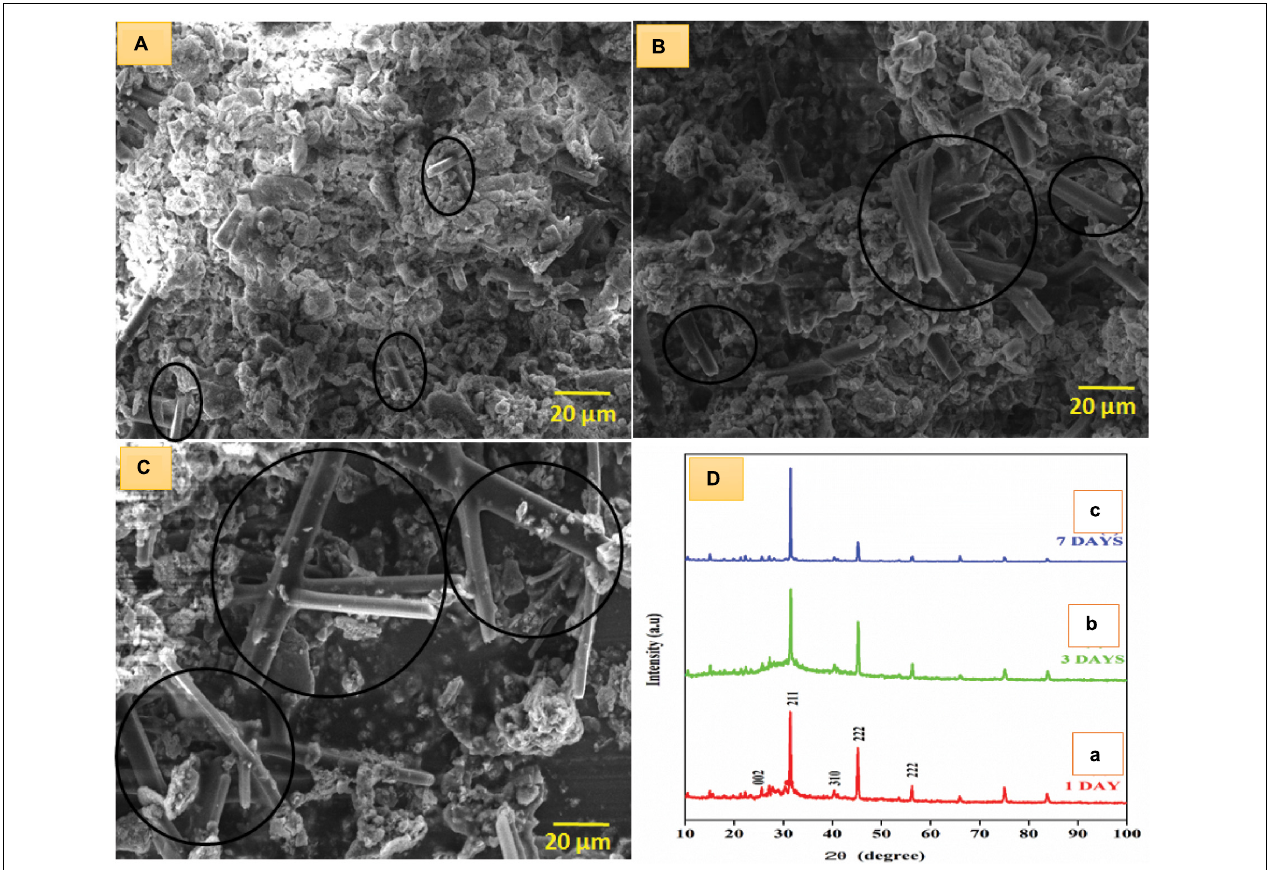
FIGURE 5 | SEM image of apatite formation on SBF immersion at (A) 1, (B) 3, and (C) 7 days and (D) XRD pattern of BM-HA/PAA/UMB composite in SBF immersion at (a) 1, (b) 3, and (c) 7 days. The black-colored circle indicates the formation of rod-like apatite